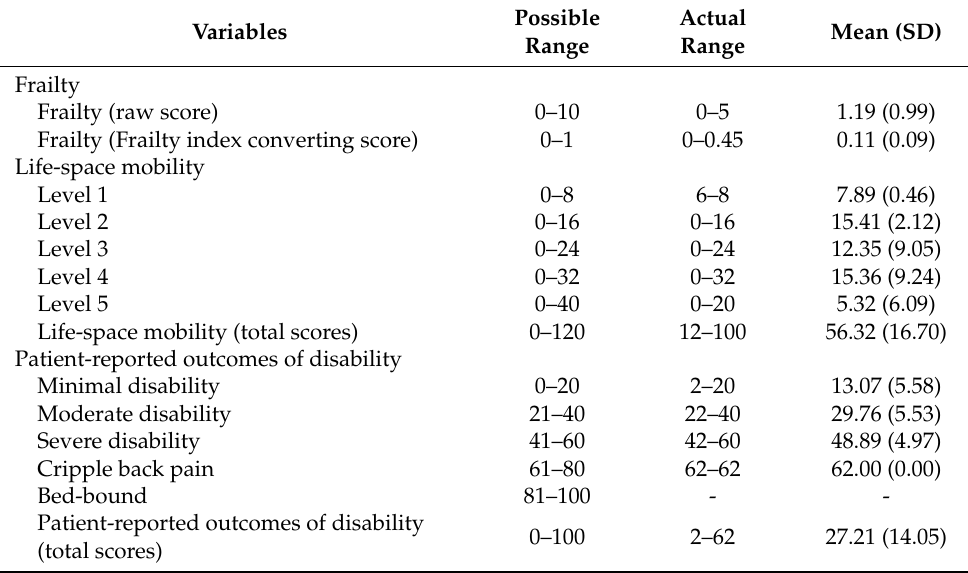
Table 2. Mean scores of frailty, life-space mobility, and patient-reported outcomes of disability (N =